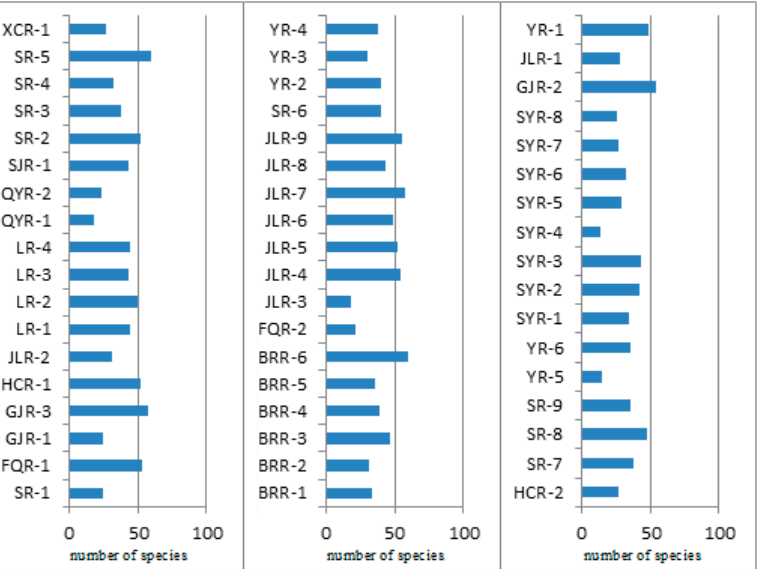
Figure 2. Number of benthic diatom species in each sampling site.